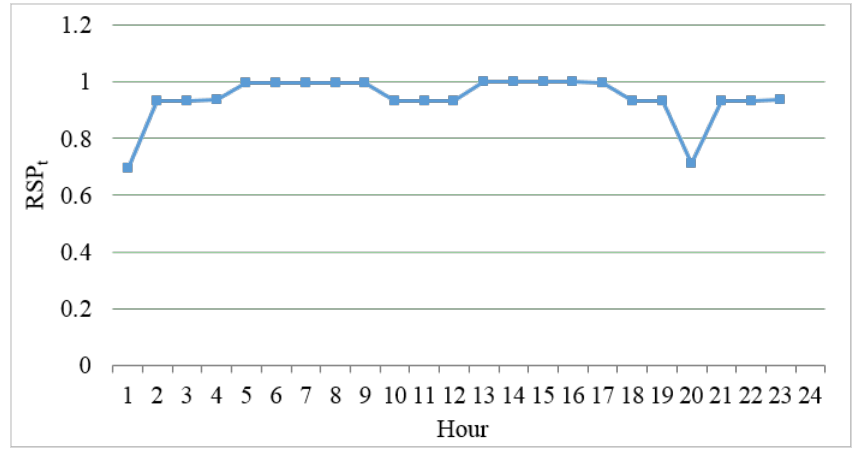
Figure 10. Hourly reserve capacity in 2029 based on the proposed method.